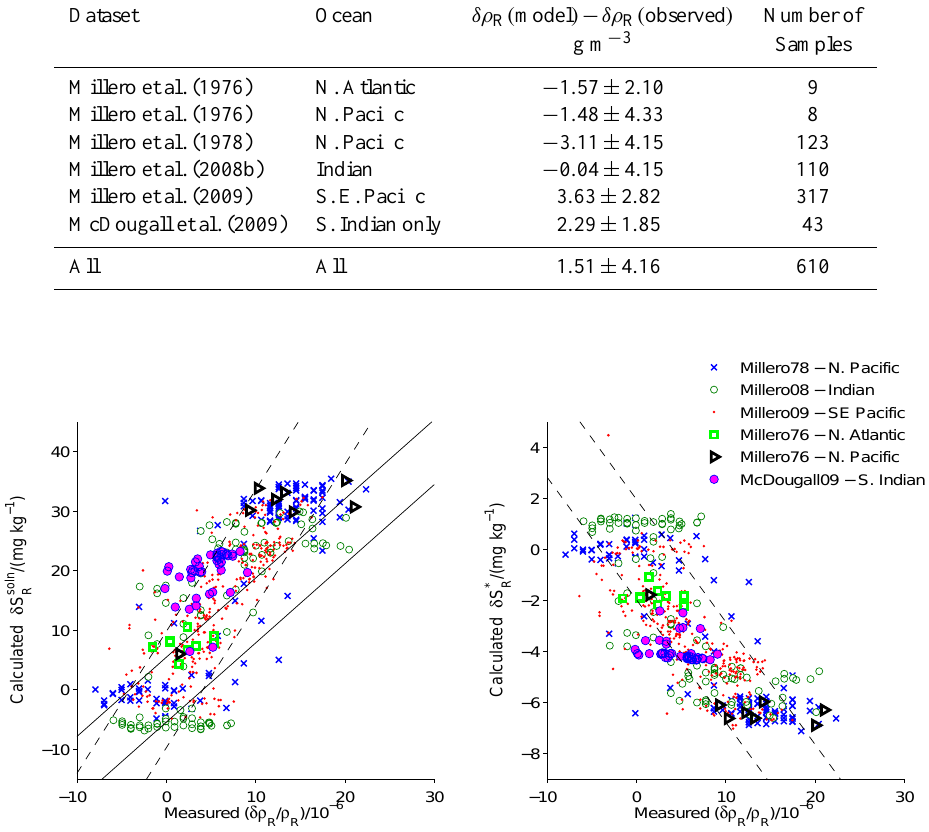
Fig. 9. (a) Comparison between observed δρ R /ρ and model-calculated δS soln by density variations of ± 0.004g m − 3 . Solid curves show the same result using β R . (b) Comparison between measured δρ R /ρ and model- calculated δS ∗ . Dashed curves show a relationship δρ R /(ρδS ∗ R